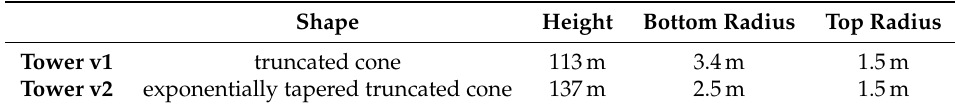
Table 2. Parameters of the wind-turbine tower models.